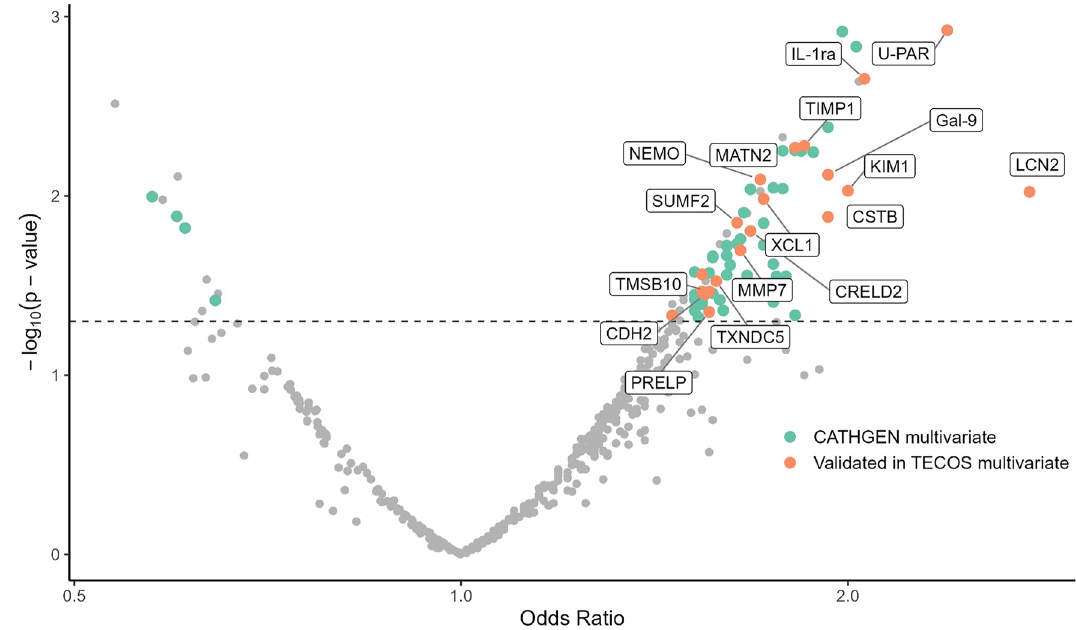
Figure 2. Proteins involved in cardiac remodeling, fibrosis and inflammation are associated with HFpEF. The volcano plot shows all 459 proteins analyzed in the study. Proteins with an odds ratio (OR) > 1.0 are upregulated in HFpEF cases compared to controls and proteins with an OR < 1.0 are downregulated. The 65 proteins significant in multivariate analyses in CATHGEN are shown in green. The 20 proteins that validated in the TECOS multivariate model are shown in